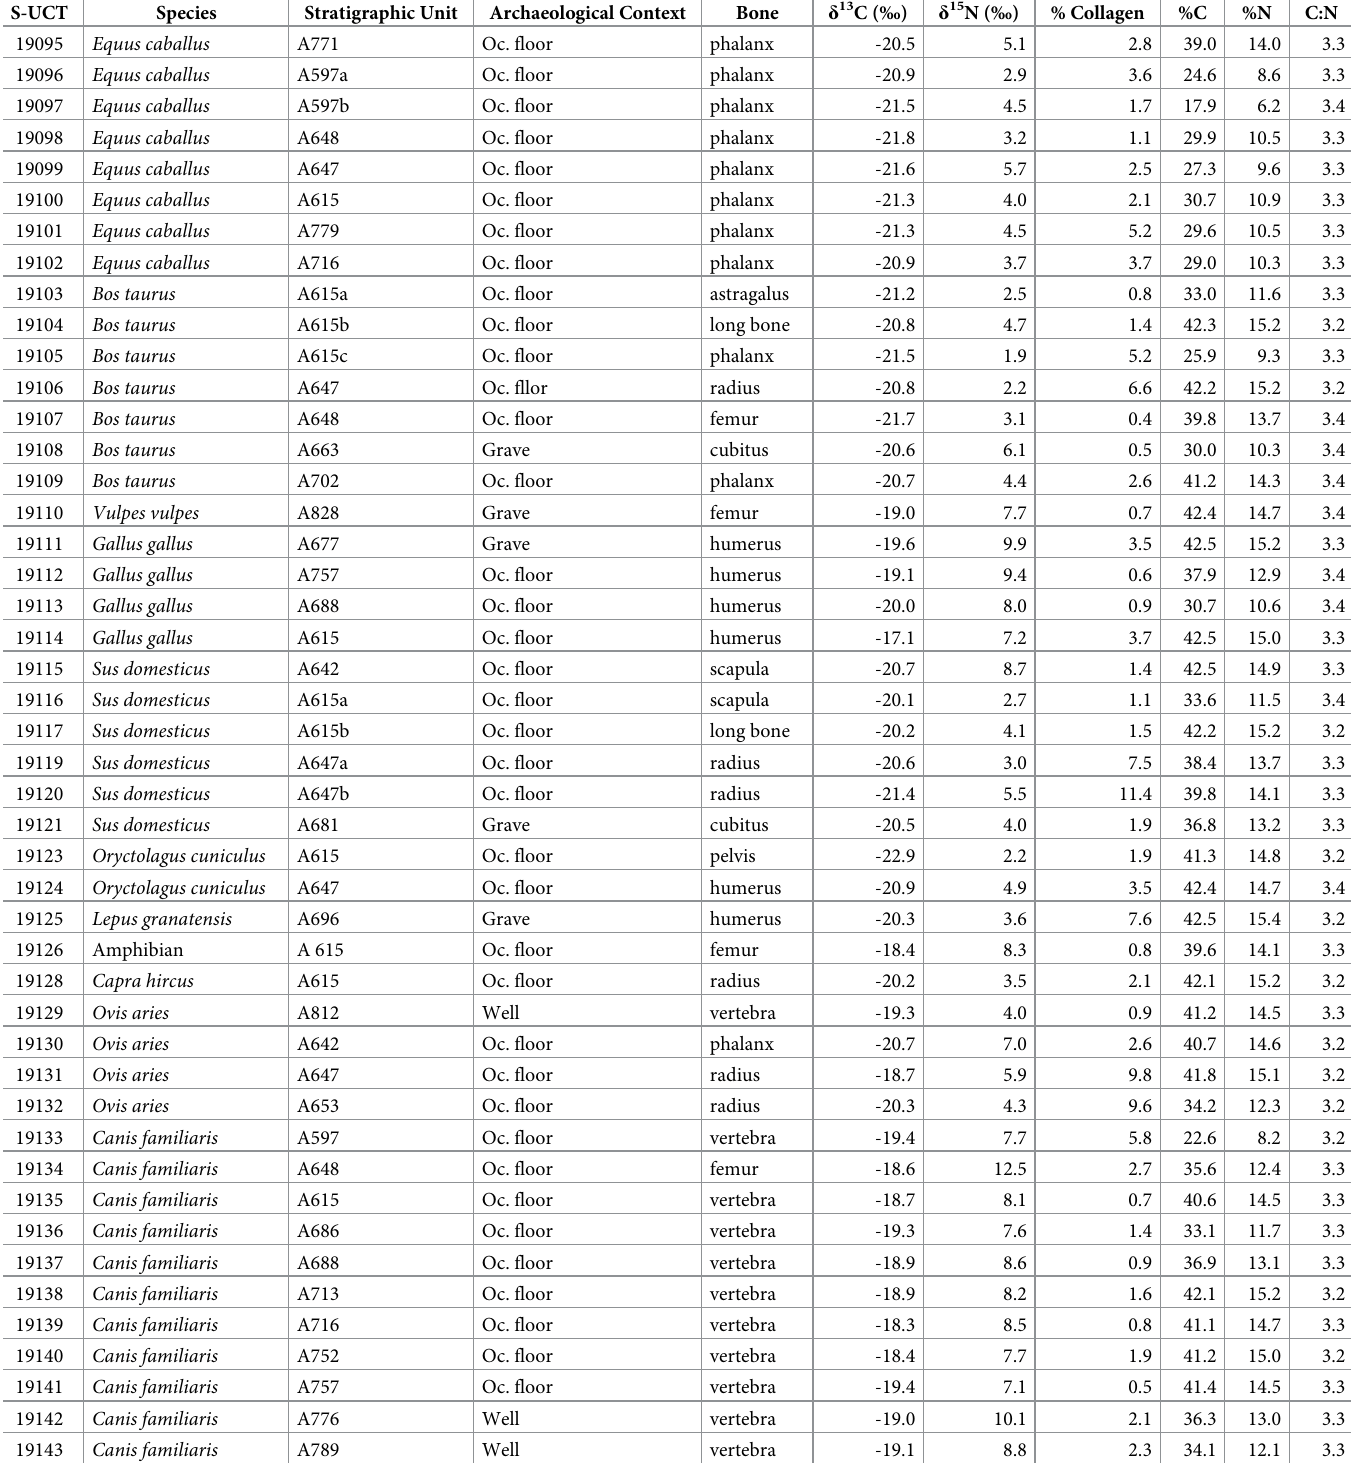
Table 1. Vila de Madrid δ 13 C and δ 15 N values from fauna, collagen control indicators (yield, %C, %N, C:N), S-UCT number (lab code), sampled bone, stratigraphic unit and archaeological context (oc. floor = occupation